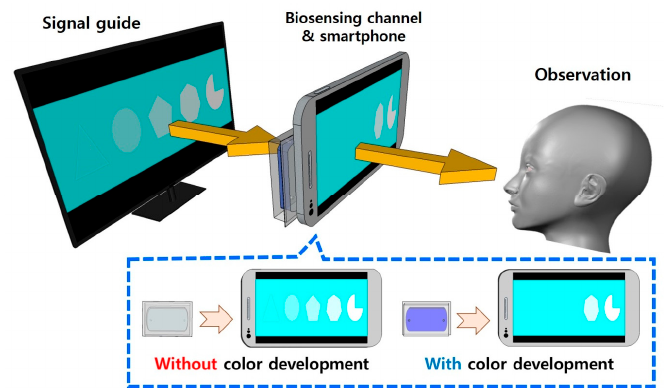
Figure 1. The scheme of the smartphone-based optical biosensing system. The numbers of signal guides on the screen were changed by superimposing a chromogen-containing biosensing channel. In the absence of a chromogen in the biosensing channel, intact clear-cut signal guides were observed, but the signal guides disappeared in the biosensing channel containing a blue product.